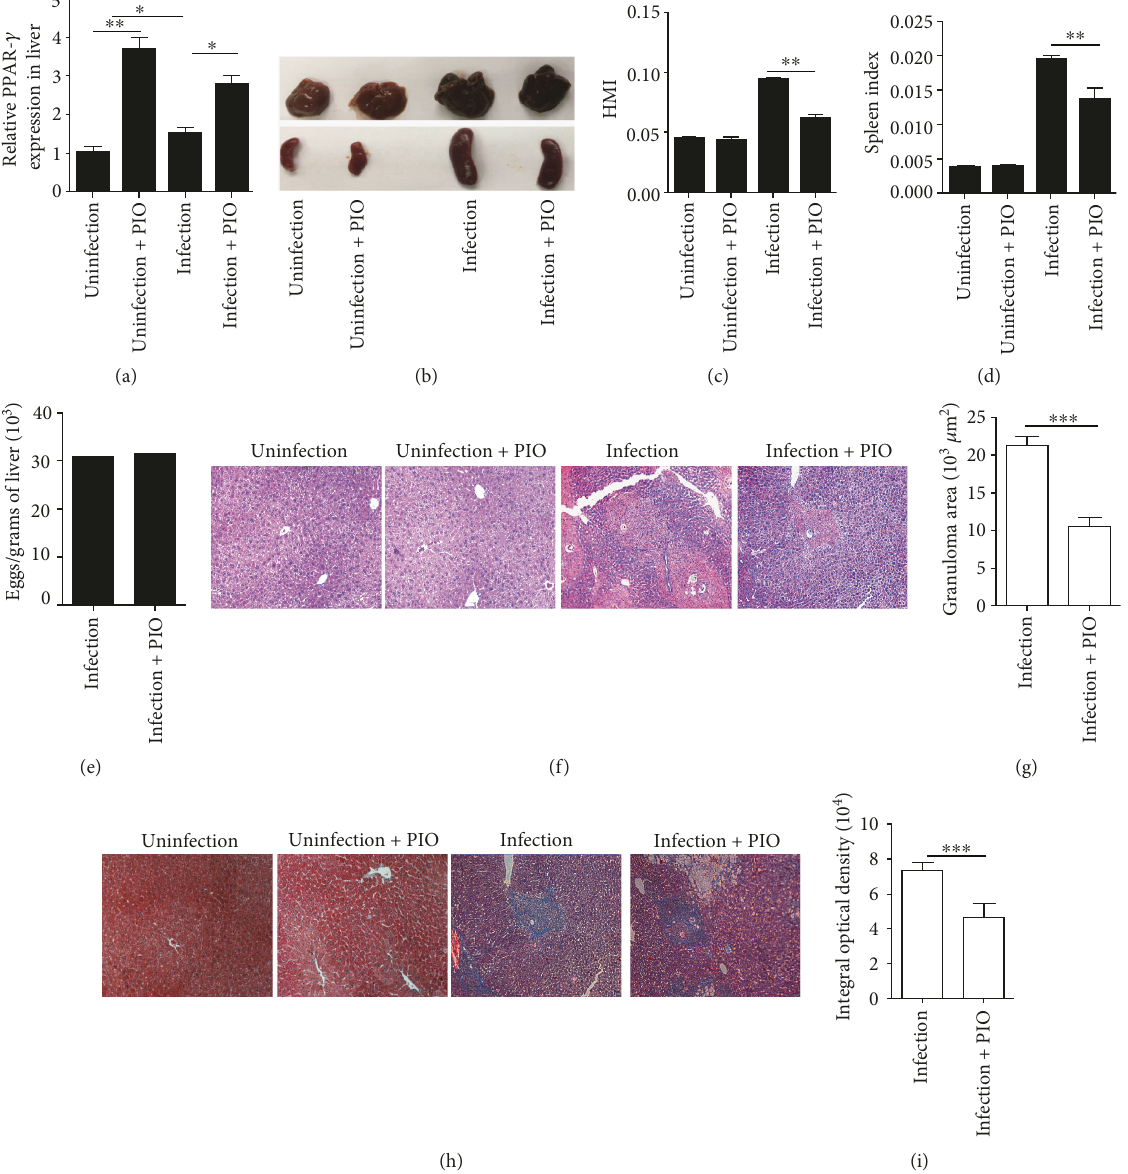
Figure 1: The role of the PPAR- γ agonist in hepatic and splenic pathologies. (a) The mRNA level of PPAR- γ in the liver of mice in each group after continuous intragastric administration with pioglitazone for 5 weeks. Data are expressed as the mean ± SD of 6 mice for each group. (b – d) Hepatic mass index (HMI) and spleen index were calculated by the ratio of the liver or the spleen weight to the body weight, respectively. (e) The numbers of eggs extracted from the liver (1 gram) in each mice were determined by microscopic examination. (f, h) Para ffi n-embedded liver sections stained with H&E or Masson; original magni fi cation, × 100. (g) For each mouse, the sizes of 20 liver granulomas around single eggs were quanti fi ed with AxioVision Rel 4.7. Para ffi n-embedded sections were stained with Masson; original magni fi cation, × 100; (i) the mean optical density of collagen fi bers by Masson staining was digitized and analyzed on Image Pro Plus software. Data are expressed as the mean ± SD of 12 mice for each group, which resulted from two independent experiments. ∗ P < 0 05 , ∗∗ P < 0 01 , and ∗∗∗ P < 0 001